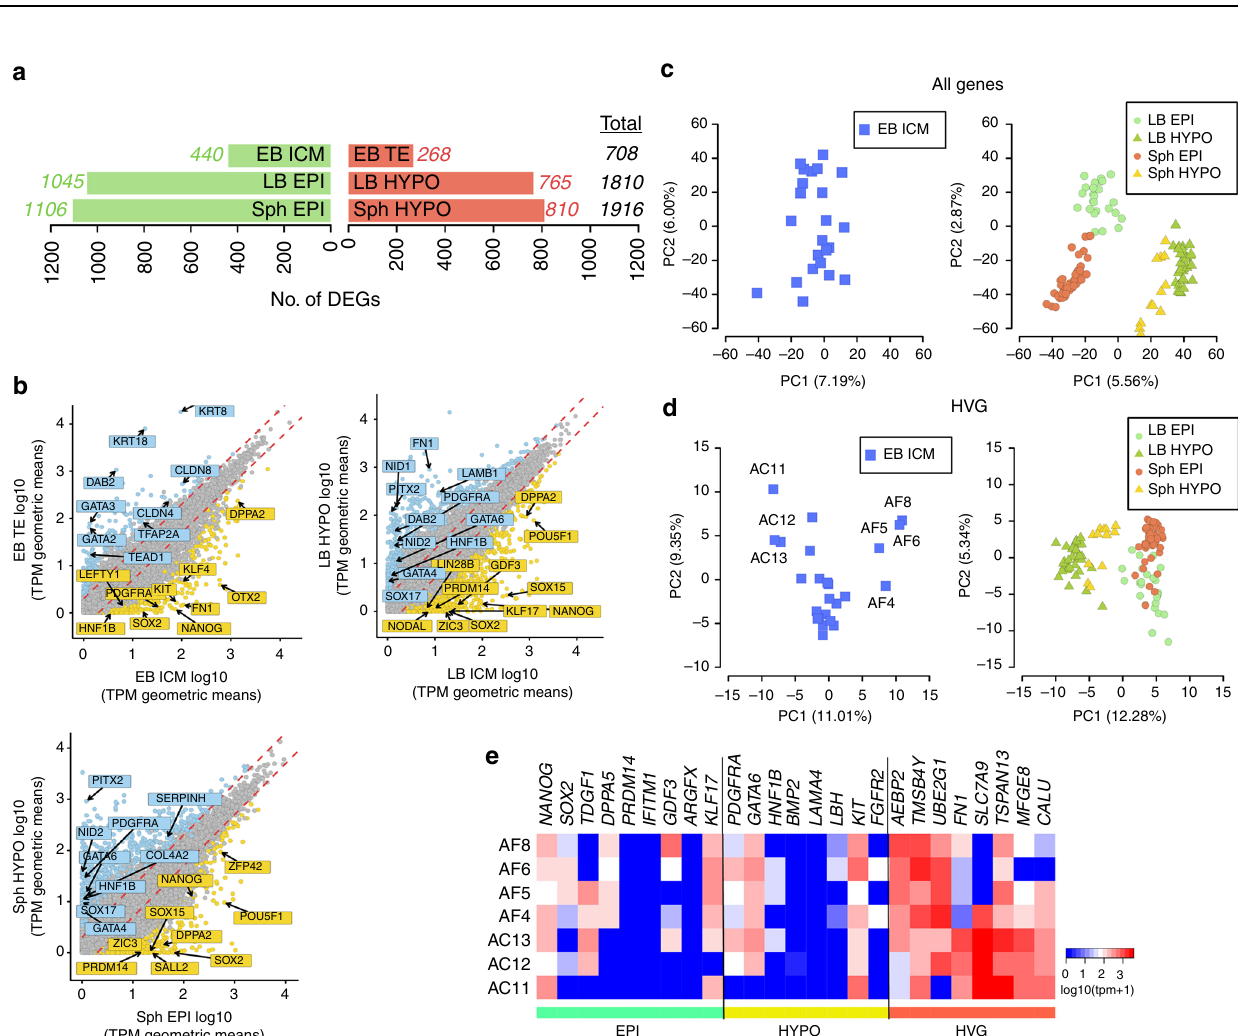
Fig. 2 Differential gene expression in cells of the early pig embryo. a Numbers of differentially expressed genes (DEGs) during lineage segregation in pairwise comparisons for each stage. Red and green bars indicate upregulated and downregulated genes, respectively. b Scatter-plot comparisons of the averaged gene expression levels between different lineages (>1 fold change, fl anking diagonal lines; Yellow: upregulated, blue: downregulated; log 10 (TPM geometric means), key genes are annotated). c PCAs of EB ICM ( n = 24 cells) and LB and Sph EPI and HYPO of all expressed genes ( n = 121 cells). d PCA of EB ICM ( n = 24 cells) and LB and Sph EPI and HYPO cells by highly variable genes (HVG) (n = 121 cells). e Heat map of expression levels of epiblast- and hypoblast-speci fi c markers and HVG in seven selected EB ICM samples from c and d . M: morula, EB: early blastocyst, LB: late blastocyst, Sph: spherical embryo, EPI: epiblast, HYPO: hypoblast, ICM: inner cell mass, TE: trophectoderm